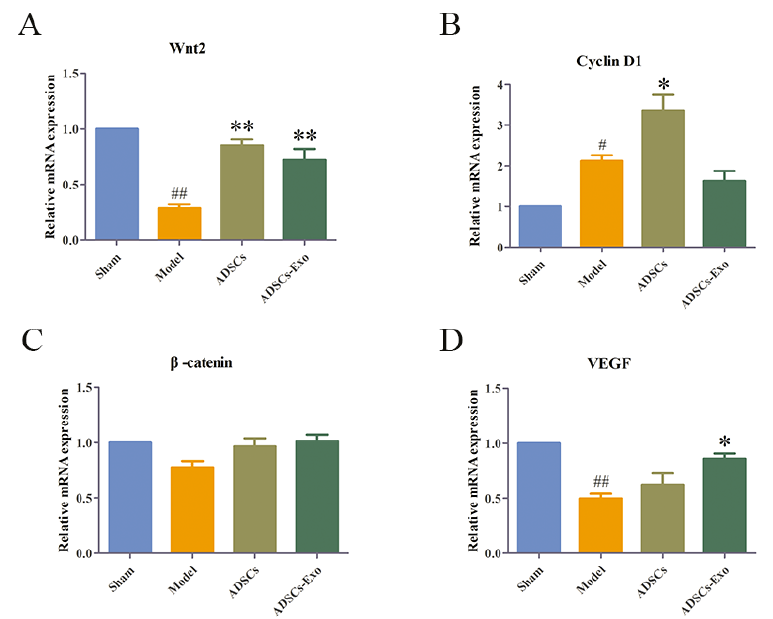
Figure 6. ADSCs-Exo increased the mRNA expression of regeneration in the liver. Level of Wnt2 ( A ), Cyclin D1 ( B ), β -catenin ( C ), and VEGF ( D ) in the liver in different groups. The data are expressed as mean ± SD. # p < 0.05 and ## p < 0.01, versus the Sham group. * p < 0.05 and ** p < 0.01, versus the Model